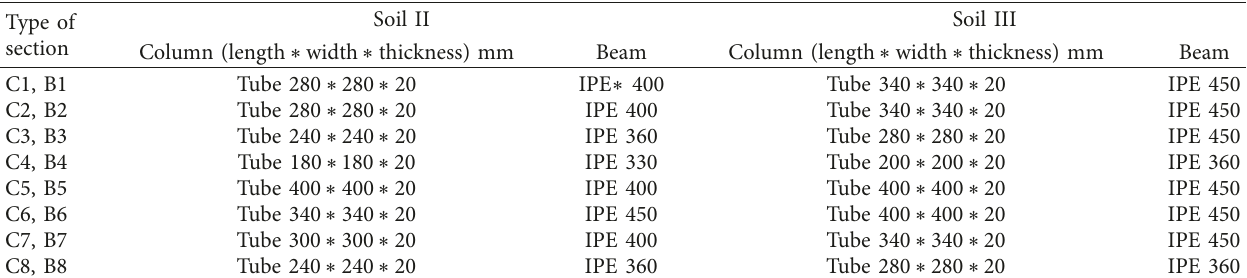
Table 3: Designed sections of a 8-story